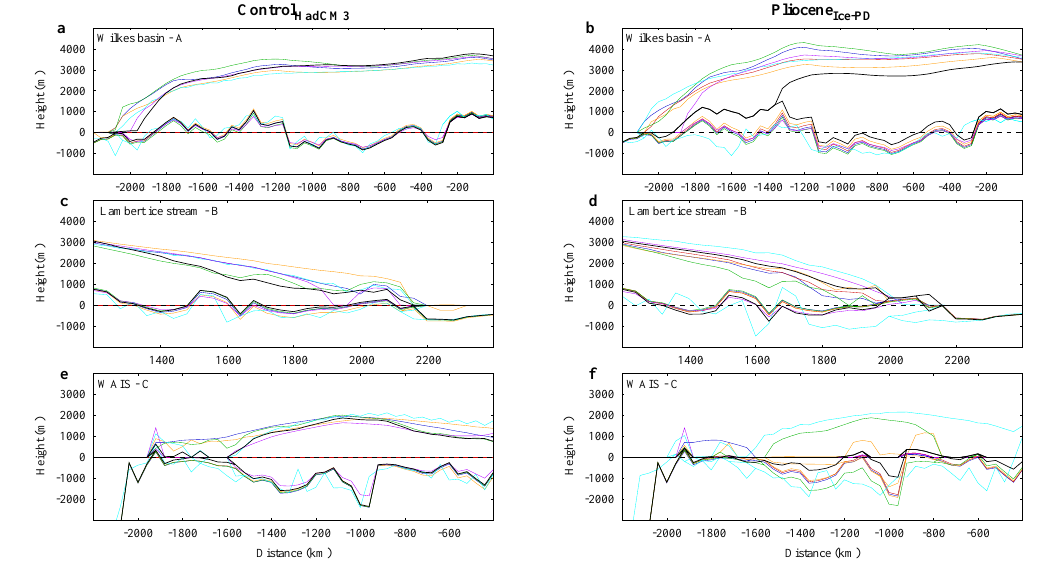
Figure 10. Cross section through the ice sheets showing surface and bedrock topographies. Cross sections as indicated in Fig. 9. Top row shows a cross section of the Wilkes basin (A), middle panels show the Lambert ice stream (B) and bottom panels, a cross section through the West Antarctic ice sheet (C). Left panels show the Control HadCM3 simulation, the right panels for the Pliocene Ice-PD simulations. The colours represent the different models and match with the lines in Fig. 2, black lines indicate the PD topography (a, c, e) and the PRISM3 topography (b, d, f) of